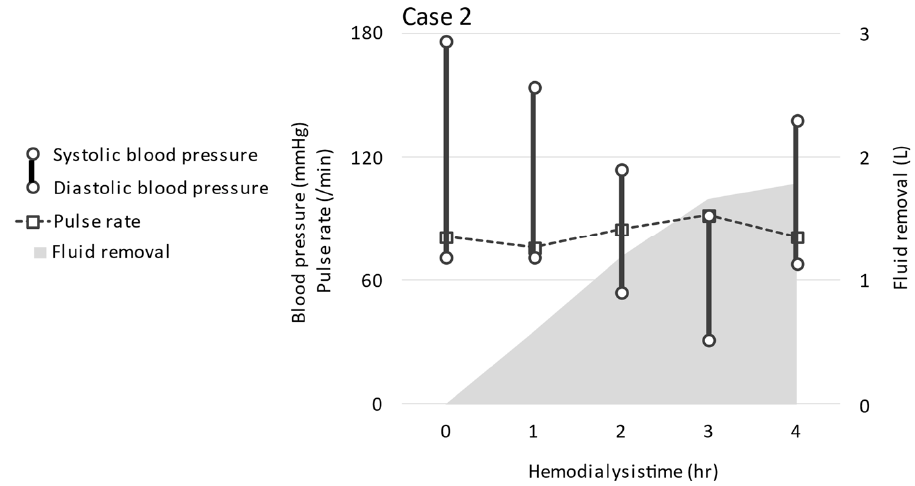
Figure 5. The trend of vital signs and fluid removal during hemodialysis in case 2.